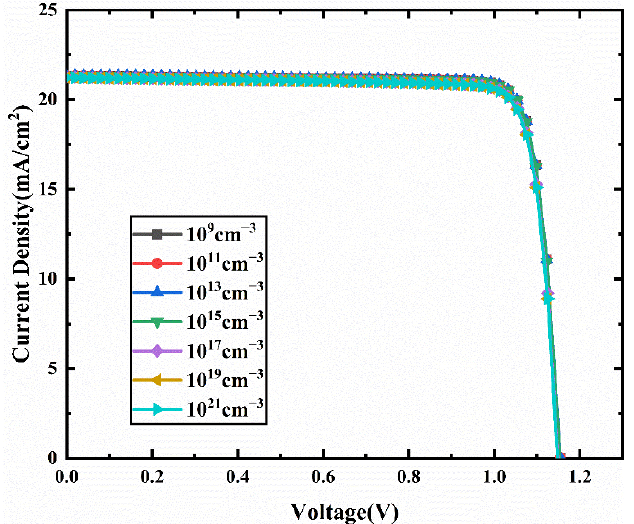
Figure 13. Comparison of J-V characteristic curves for different Cu 2 O/CCSCNCs interface layer defect density.